Question: Judging by this figure, is the value going up or going down?
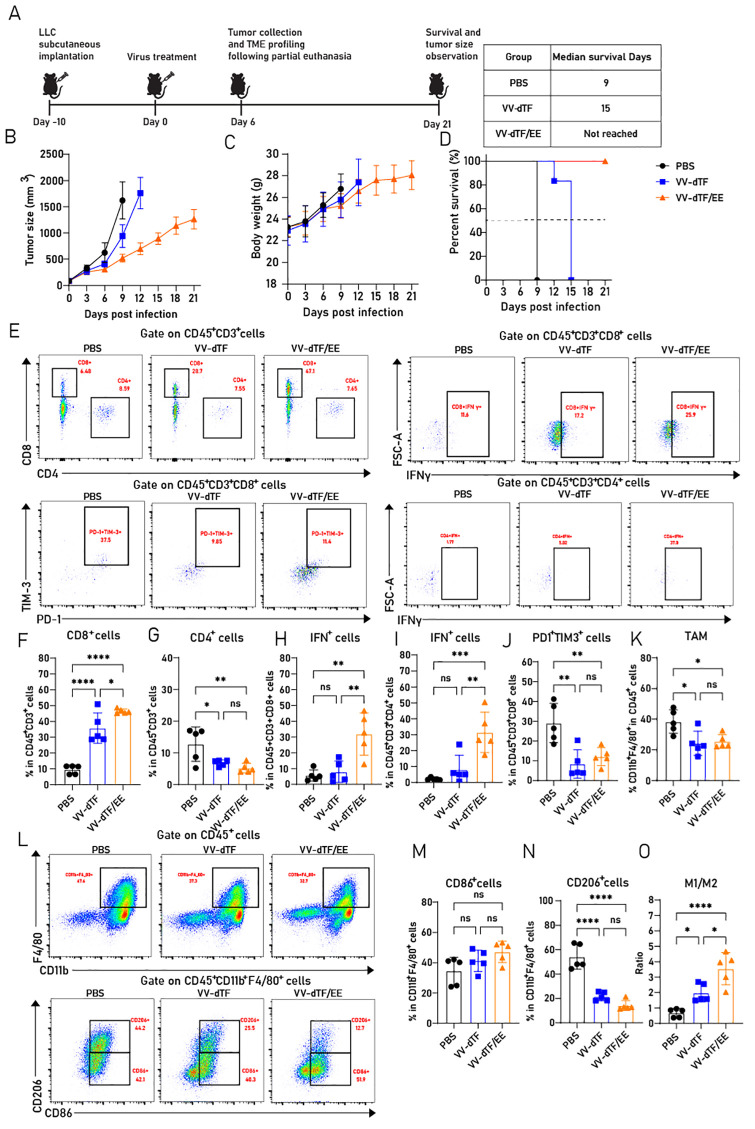
Answer: increasing